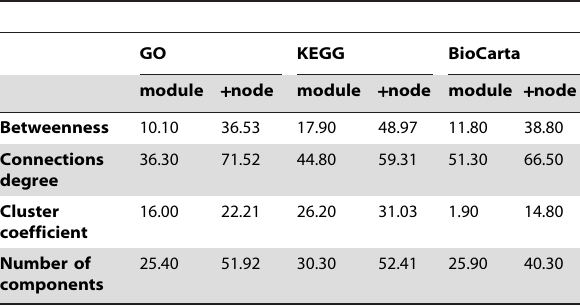
Table 1. Percentage of significant network parameters (p , 0.05) in the different conceptual module definitions.